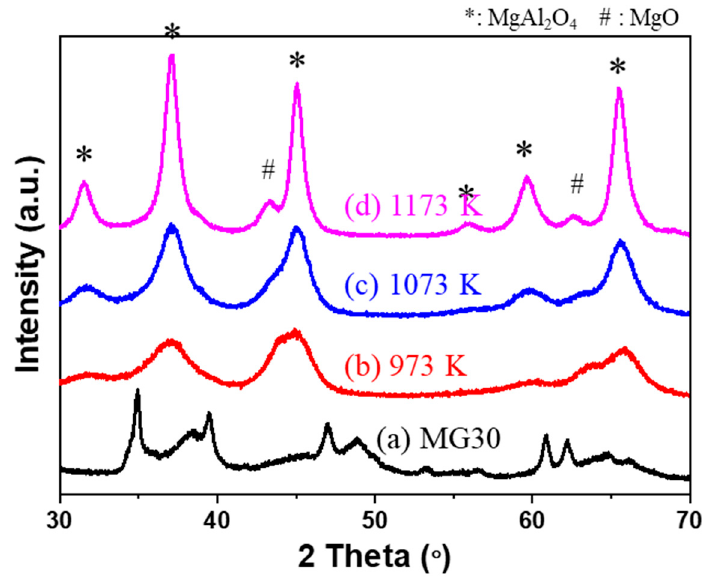
Figure 1. XRD patterns of MgAl 2 O 4 powders after the first calcination and MG30 before calcination.